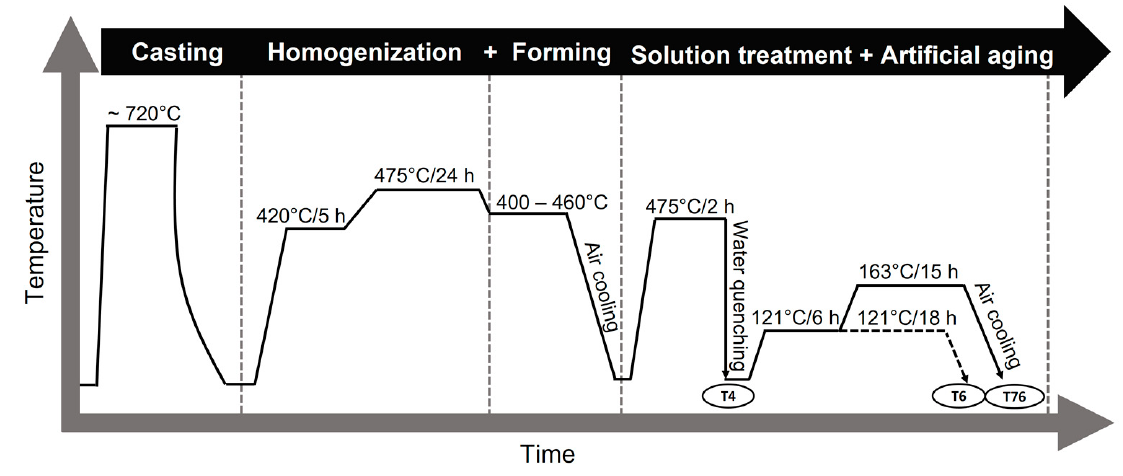
Figure 1. Summary of the processing route for investigated alloys.